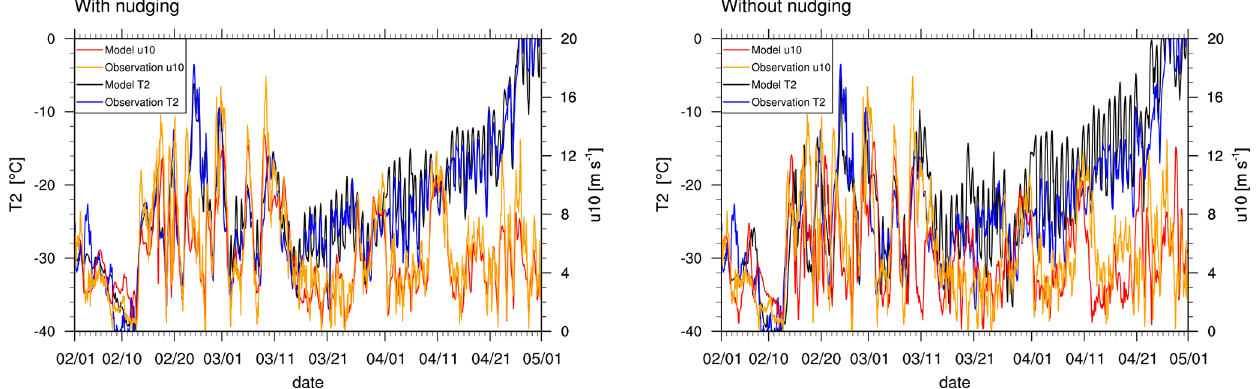
Figure 2. Profiles of 2m temperature and 10m wind speed at Utqia˙gvik in February through May 2009. The data are shown at 06:00GMT + 0. Measurements are taken from the Barrow Atmospheric Baseline Observatory (Mefford et al.,